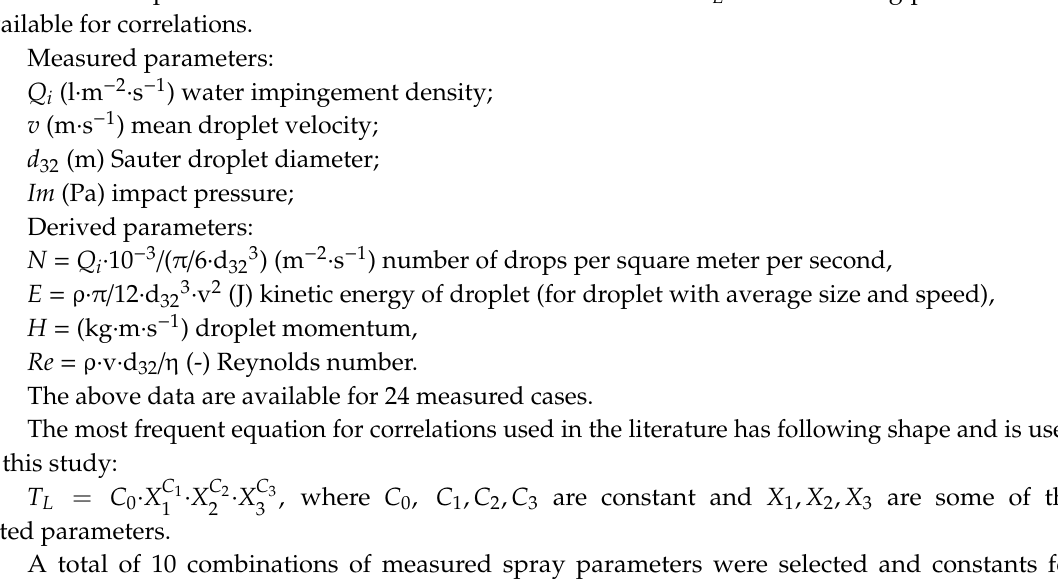
Figure 8. Droplet velocity distribution for experiments 9 and 10, identical nozzle, identical water flowrate, air pressure 1.5 bar left ( a ), air pressure 3.0 bar right ( b ), cumulative percentage orange line.